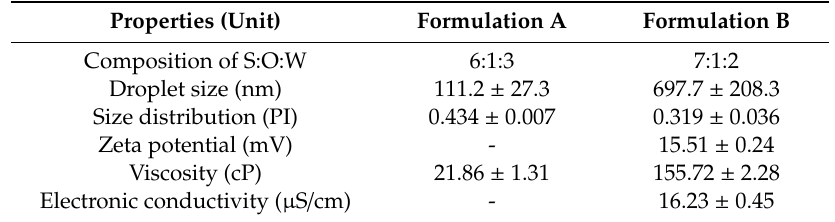
Table 1. The physicochemical properties of the two selected microemulsions. (Mean ± SD, n = 3).